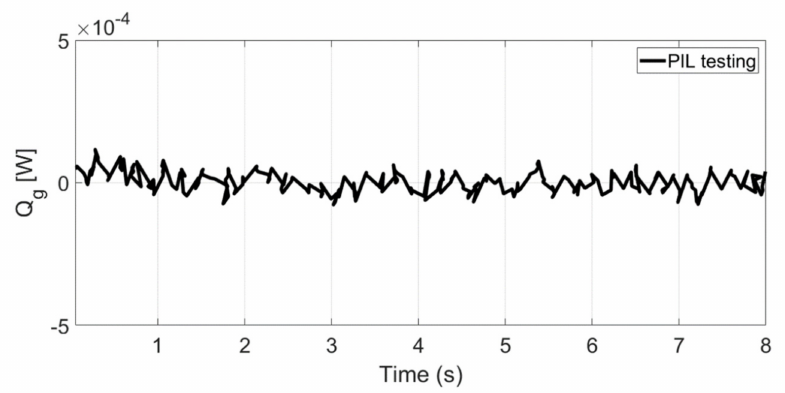
Figure 24. Reactive